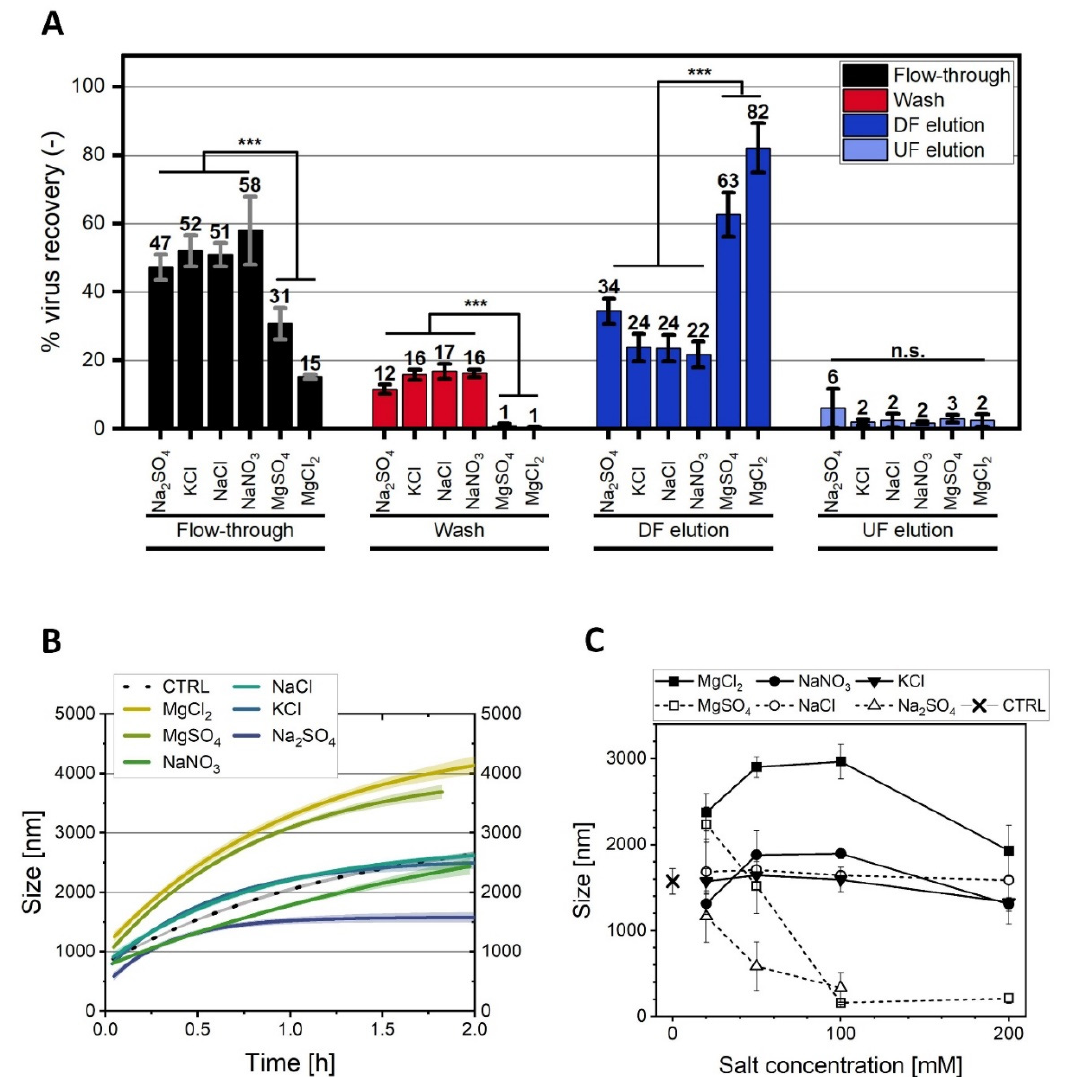
Figure 5. Variation of the salt type throughout the steric exclusion chromatography (SXC). The Orf virus (ORFV) was processed via SXC (load: 8% PEG 6000 (polyethylene glycol, 6000 Da); elution: 0% PEG, 0.4 M NaCl) in 20 mM TRIS buffer, pH 7.4, supplemented with 20 mM of different salts, i.e., Na 2 SO 4 , KCl, NaCl, NaNO 3 , MgSO 4 , and MgCl 2 . The load was stopped when the pressure limit of 0.4 MPa was reached or 40 mL PEG/ORFV suspension were loaded. The fractions load